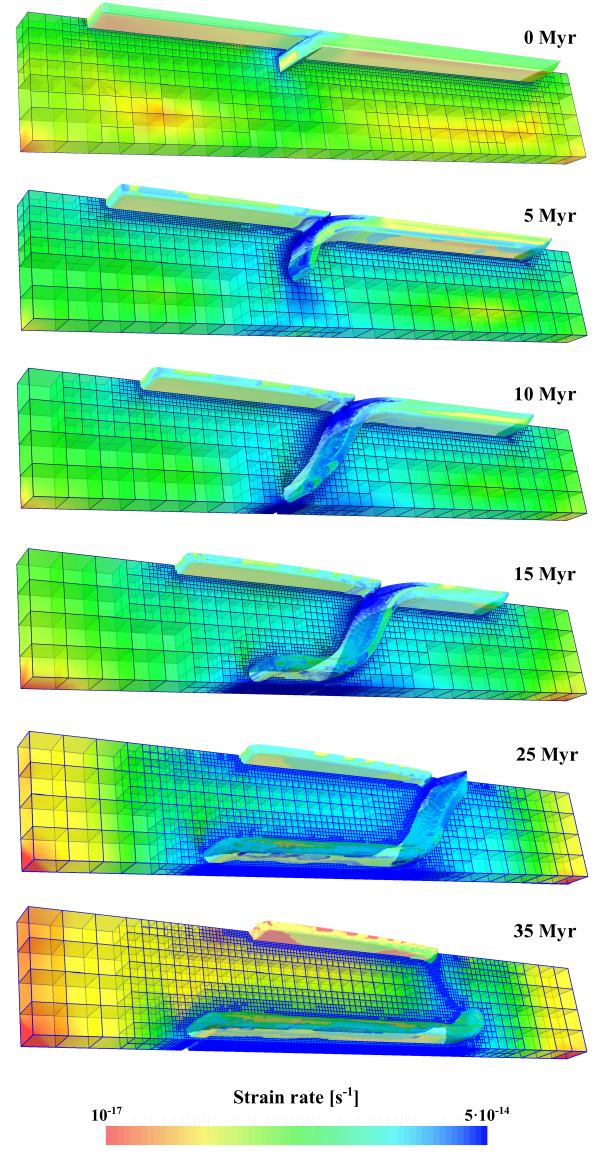
√ Figure 18. Model 2 – strain rate Frobenius norm ˙ (cid:15) : ˙ (cid:15) over time together with SP, SP crust and OP isocontours. Also shown is the adaptive mesh following the SP into the